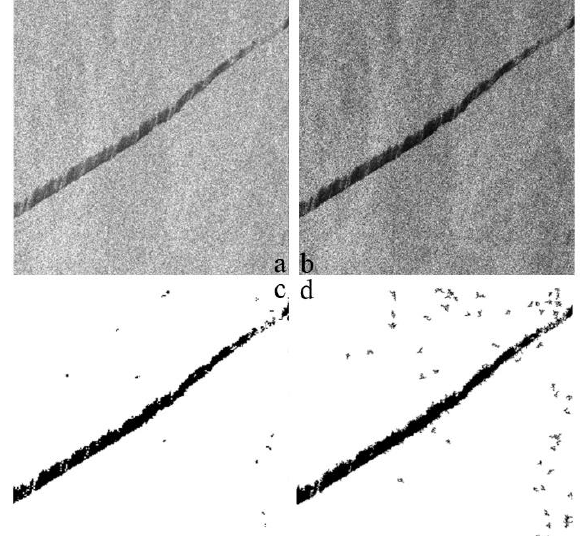
Fig.2. Results of the proposed approach on a not well-defined linear dark spot within a homogeneous background. (a) Original SAR images after pre-processing. (b) WMM Filtering with P=0.7, window 3x3. (c) MLP result. (Fourth Col) PCNN